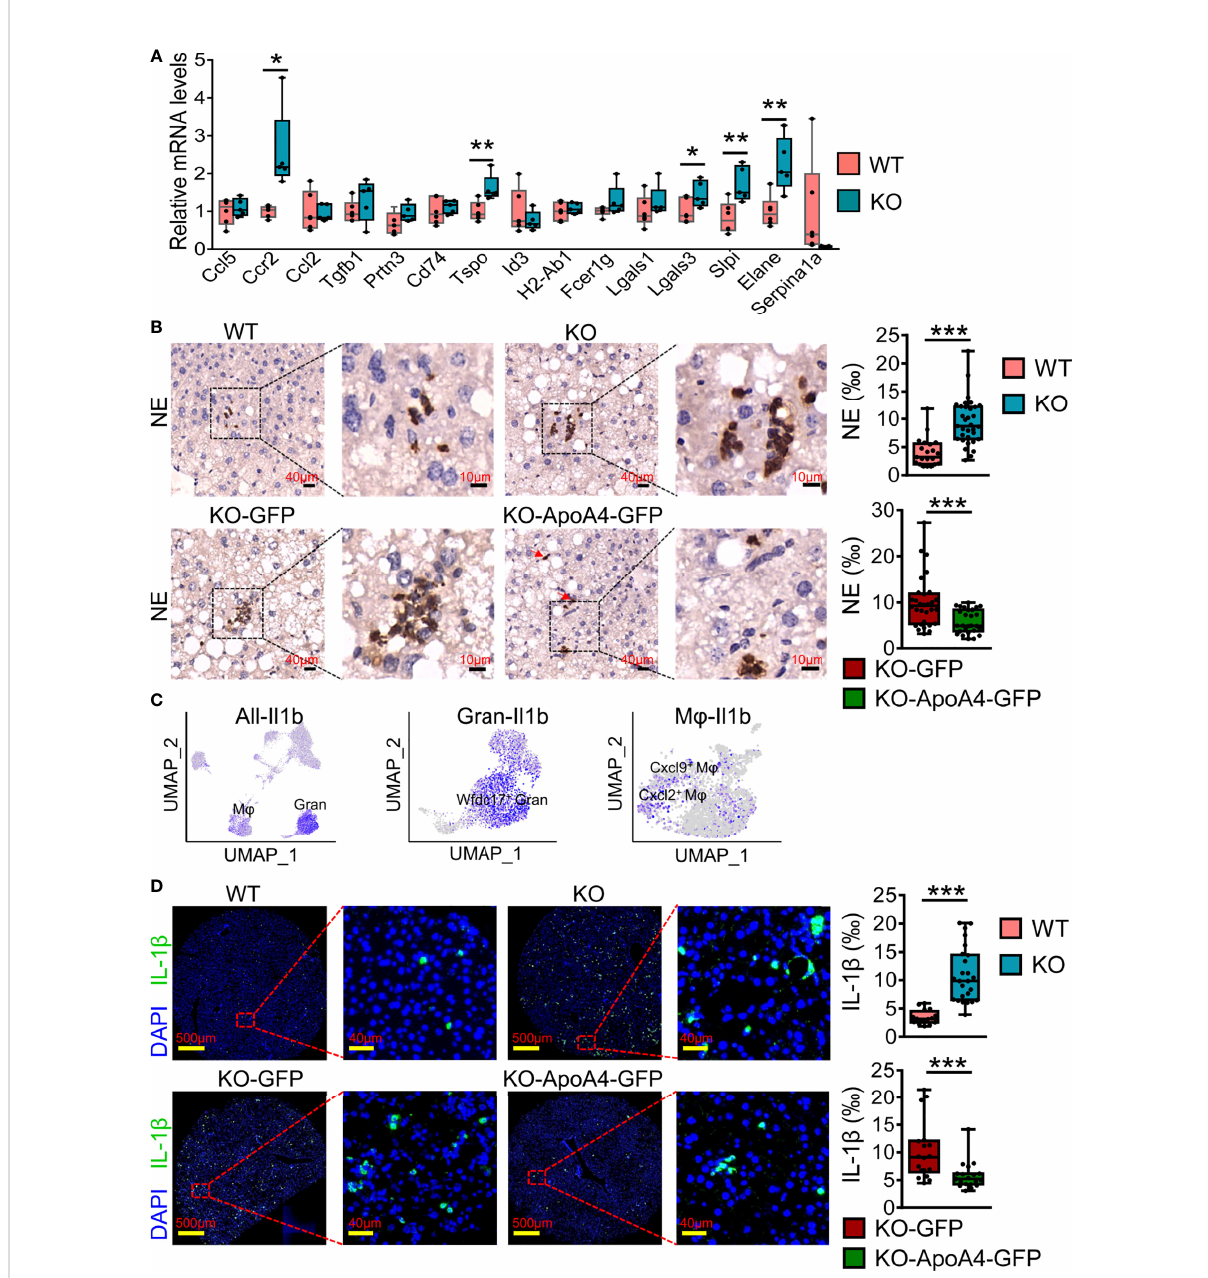
FIGURE 5 ScRNA-seq data were further validated by qRT – PCR and immune staining in enlarged samples. (A) Liver qRT – PCR analysis for representative DEGs found in scRNA-seq analysis in mice fed a HFD for 16 weeks (n = 5-6). The results are expressed as the mean ± SEM. Boxes include the values from the fi rst to third quartiles, whereas horizontal bars represent the medians. Data were analyzed using two-way ANOVA. * P < 0.05, ** P < 0.01, vs. WT. (B) NE (neutrophil elastase) immunostaining experiments in liver paraf fi n sections for HFD sections; zoomed in areas with quanti fi cation of positive cells from multiple views in liver sections. (C) Feature plot of the in fl ammatory gene Il1b in all immune cell (left), granulocyte (Gran, middle) and macrophage (M j , right) subsets. (D) IL-1 b immunostaining experiments in murine liver paraf fi n sections with DAPI nuclear counterstain and the quanti fi cation of positive cells from multiple views in liver sections. Data are presented as the mean ± standard error of the mean. The statistical signi fi cance of differences was assessed with Student ’ s t test, *** P < 0.001. KO-GFP: KO-GFP group, which were ApoA4 knockout NAFL mice subjected to AAV- GFP adenoviral infection as a control; KO-ApoA4-GFP: KO-ApoA4-GFP group, which were ApoA4 knockout NAFL mice with ApoA4 stable overexpression induced by AAV- ApoA4 - GFP adenoviral